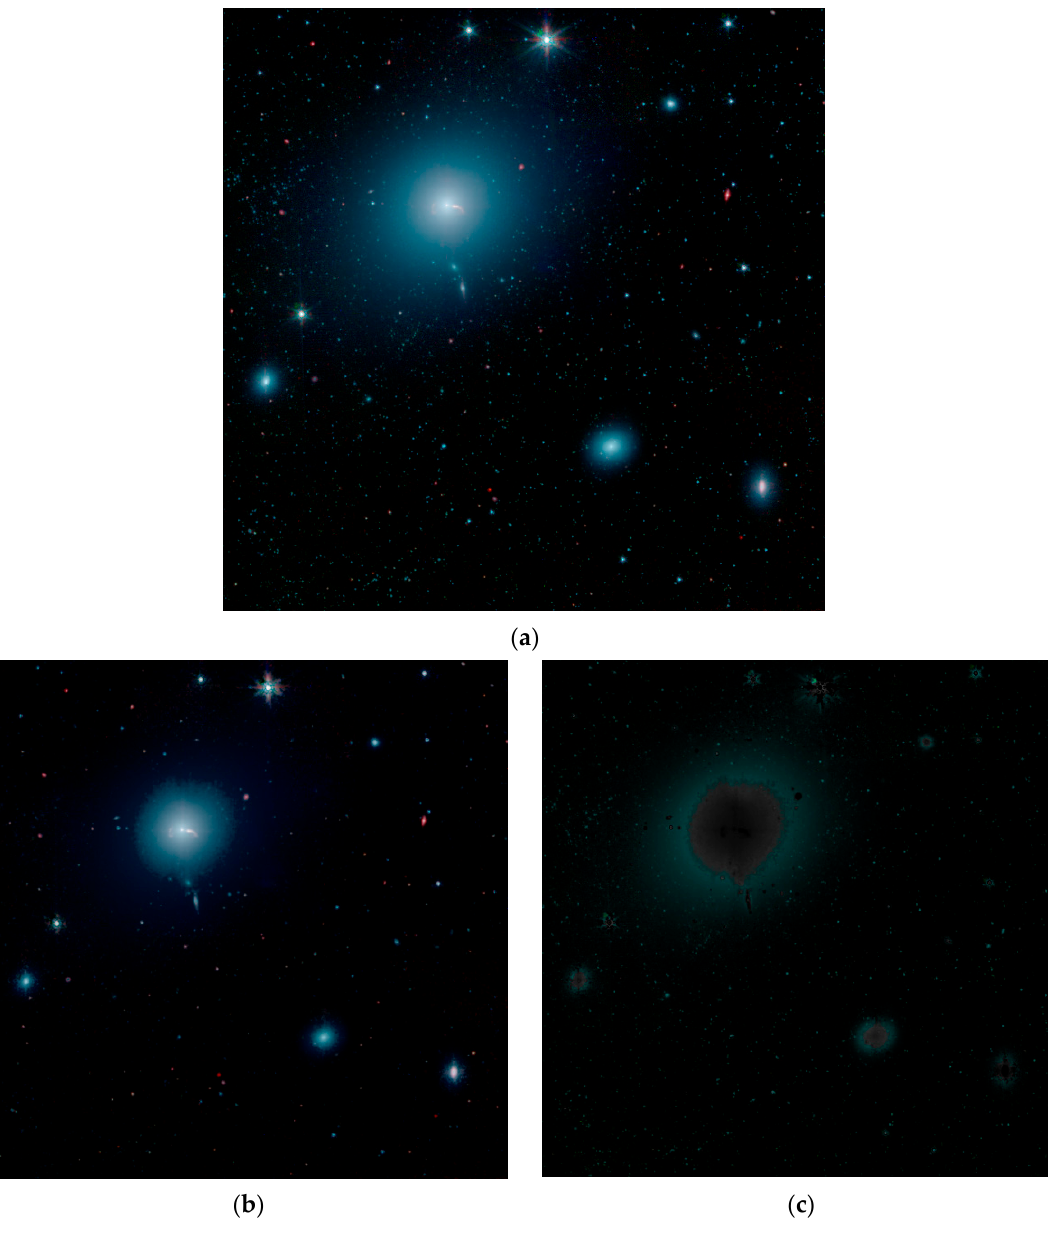
Figure 2. Image results for a full-sized tagged image file (TIF)-format image of M87 ( a ) original high resolution, credited to NASA/JPL-Caltech/IPAC, ( b ) ISED-generated image for the sixth ensemble state condition, and ( c ) image of the sixth ISED filter.